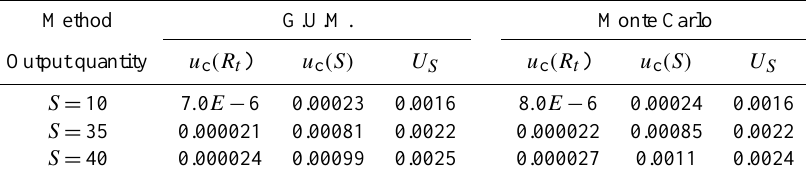
Table 2. Standard uncertainties of R t and S , and expanded uncertainty on the corrected value of S , calculated using the two methods for three different salinities. These values do not take into account possible long term variations in KCl standard solutions used to adjust standard seawater bottles, or the limits of metrological standards in terms of long term traceability of the